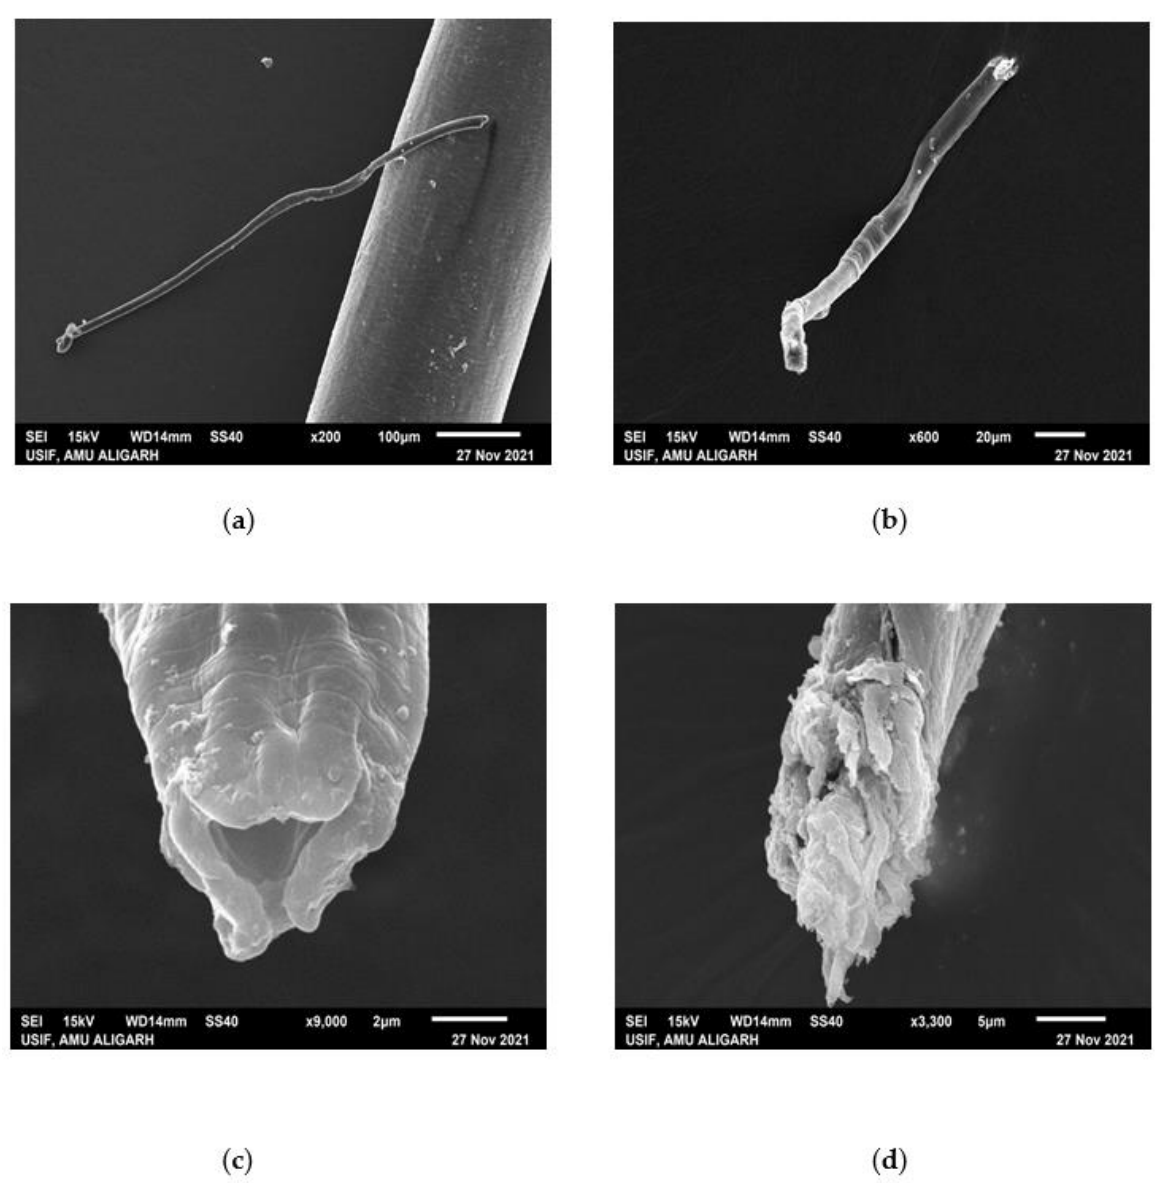
Figure 6. SEM micrograph of untreated ( a , c ) and treated ( b , d ) Meloidogyne incognita . Untreated ( a , c ) shows no splitting and no deformation in the body of the nematode, whereas ( b , d ) when treated with G. lucidum for 3 days, clear deformation was found on the body of the nematode.